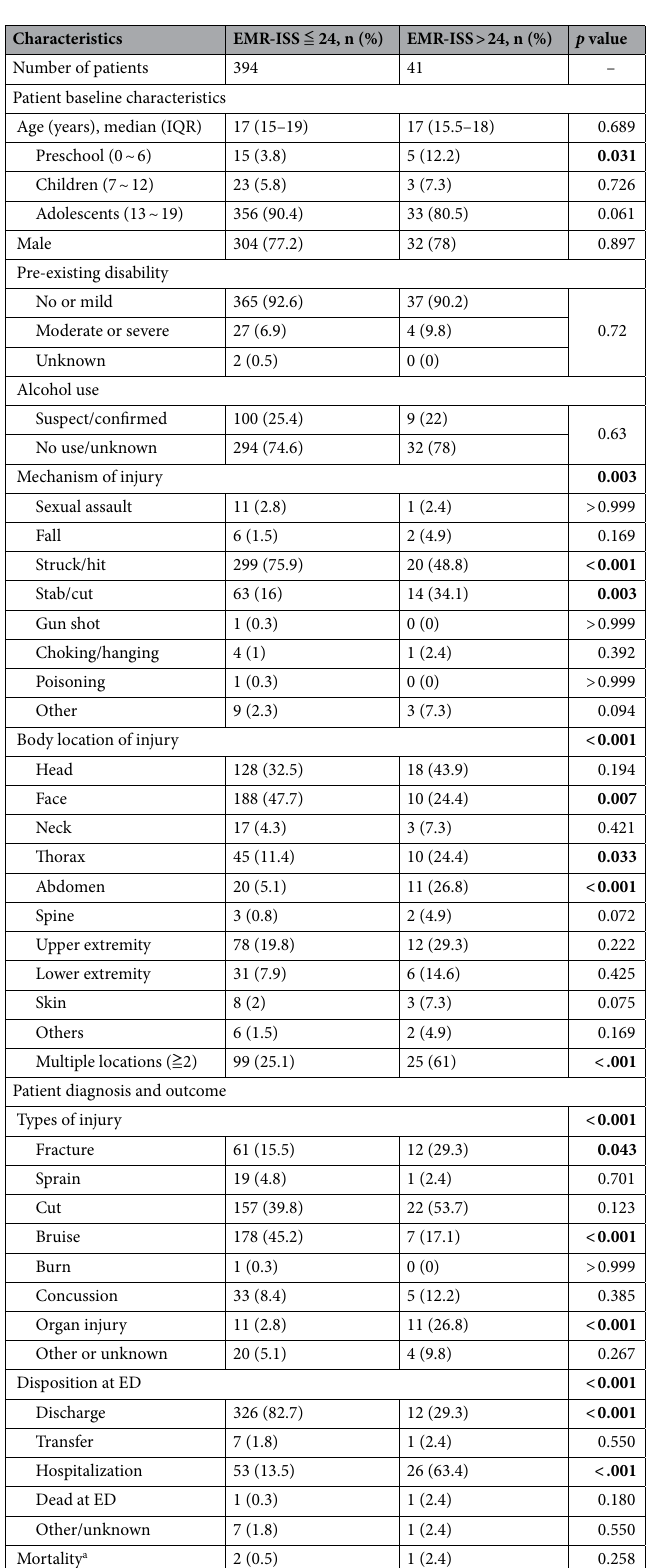
Table 2. Comparisons of baseline characteristics of non-major and major trauma (N = 435). ED emergency department, EMR-ISS excess mortality ratio-adjusted injury severity score, IQR interquartile range. a One with missing EMR-ISS. Significant values are in